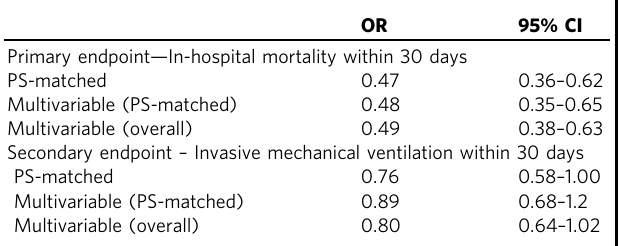
Table 4 Associations between statin use with primary and second endpoints in propensity-matched cohort and multivariable-adjusted overall cohorts of patients hospitalized with COVID-19.